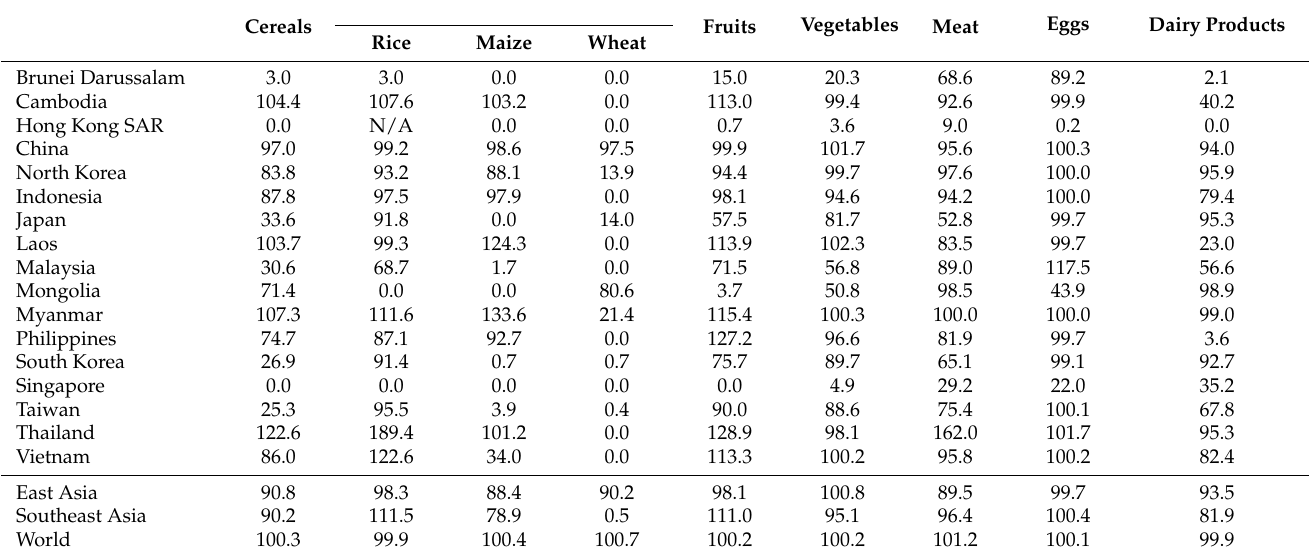
Table 5. Self-sufficiency ratios (SSRs) for major food commodities in East and Southeast Asia, 2017– 2019 (%). Cereals Fruits Vegetables Meat Eggs Dairy Products Rice Maize Wheat